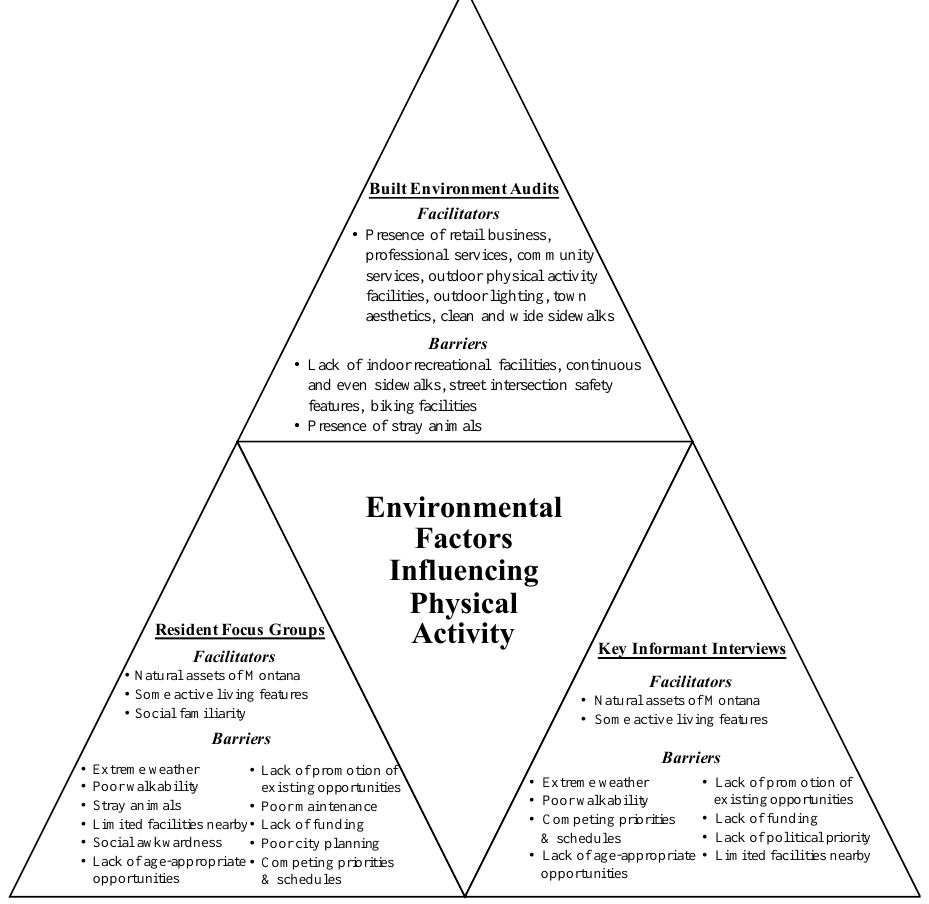
Figure 2. Sub-themes identified with each data source: built environment audits, resident focus groups, and key informant interviews.